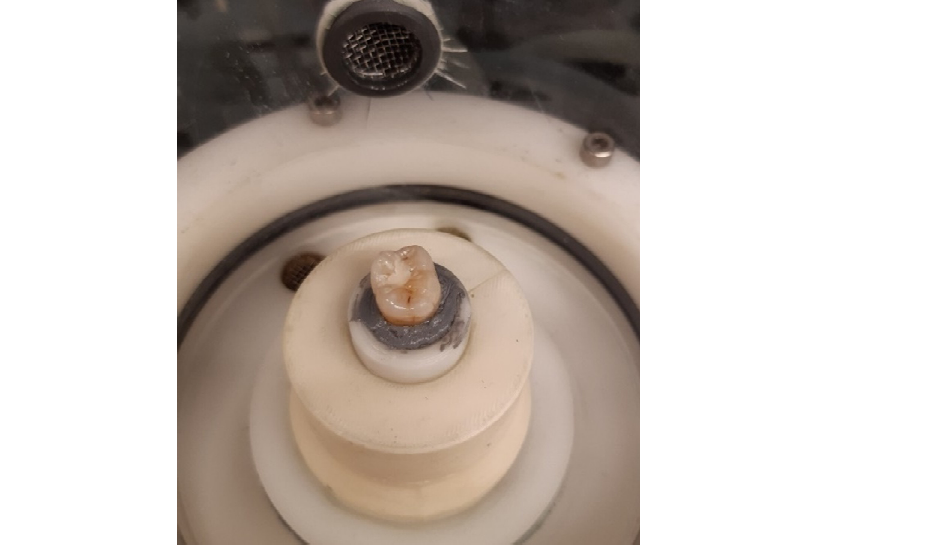
Figure 1. Chewing simulation setup with a restored tooth (DeltaFil—Specimen 4) mounted inside the chamber of the chewing simulator.